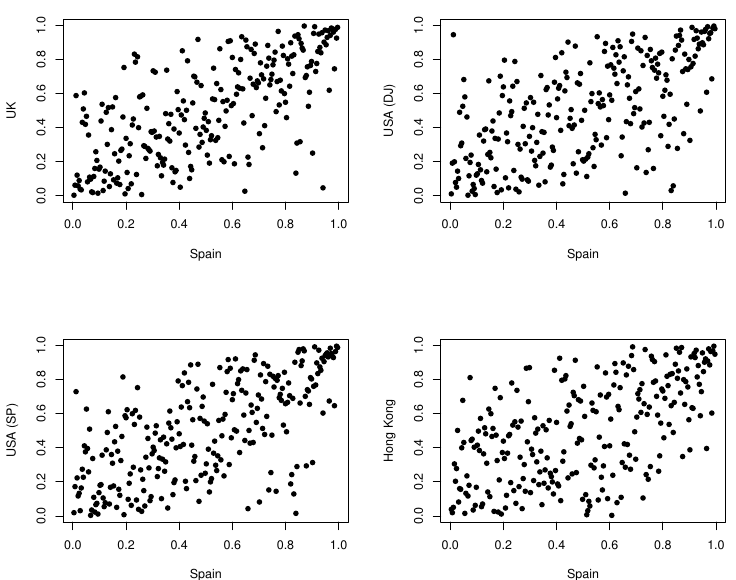
Figure 4. Pseudo-data for each bivariate copula between Spain and UK, USA (DJ and SP) and Hong